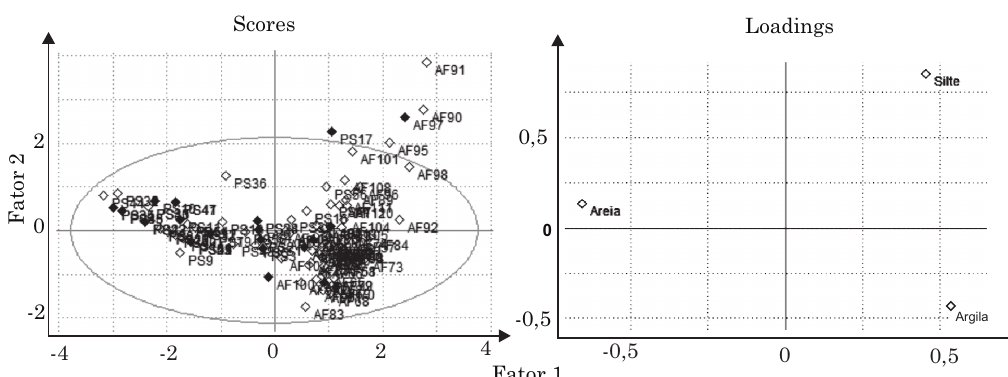
Figura 1. Gráficos de distribuição das amostras (scores) com base nas quantidades de areia, silte e argila ( loadings ) provenientes da análise de componentes principais (PCA). Ícones preenchidos representam amostras selecionadas para a validação